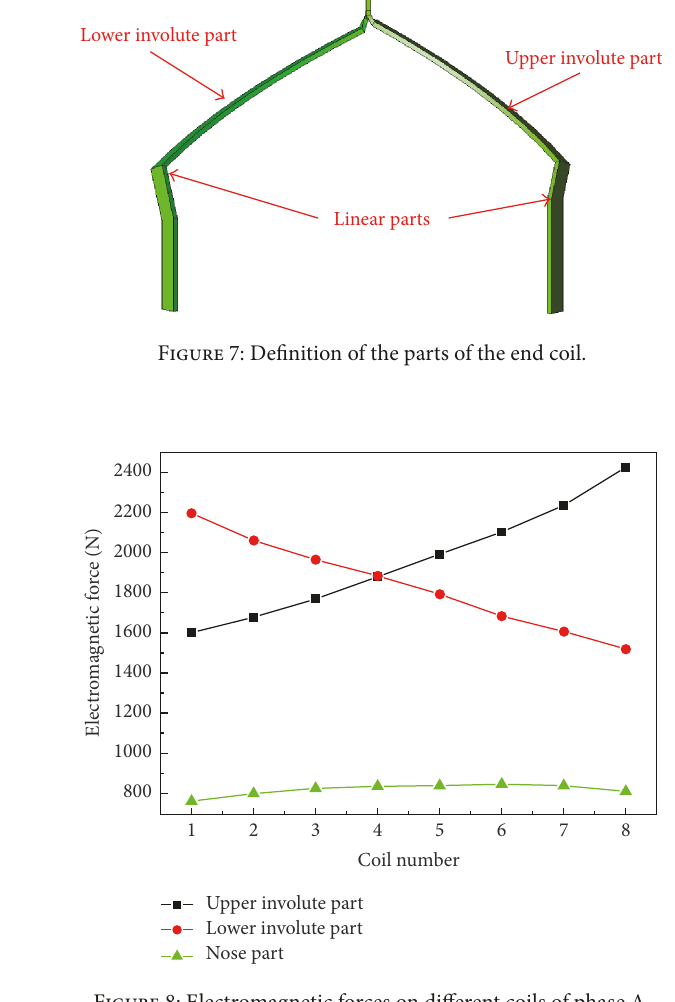
Figure 8: Electromagnetic forces on different coils of phase